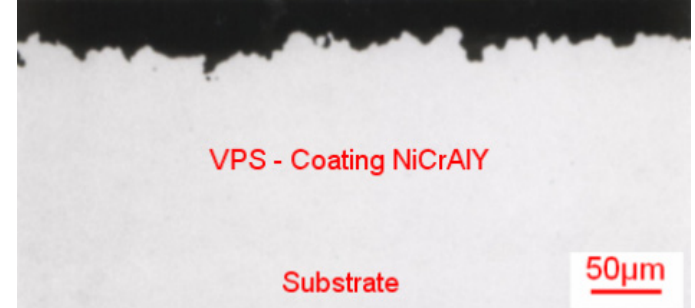
Figure 2 – (OM) micrograph of the vacuum plasma sprayed Ni22Cr10Al1Y coating Рис . 2 – ( ОМ ) микрография вакуумного плазменного напыления Ni22Cr10Al1Y